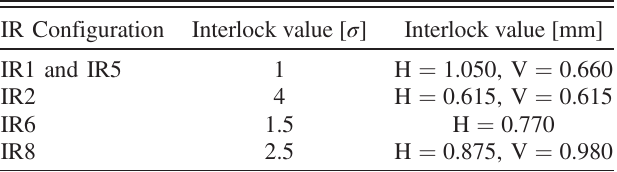
TABLE II. Proposed beam orbit interlock thresholds for the collimator BPMs for operation at 6.5 TeV with squeezed beams ( β (cid:1) ¼ 40